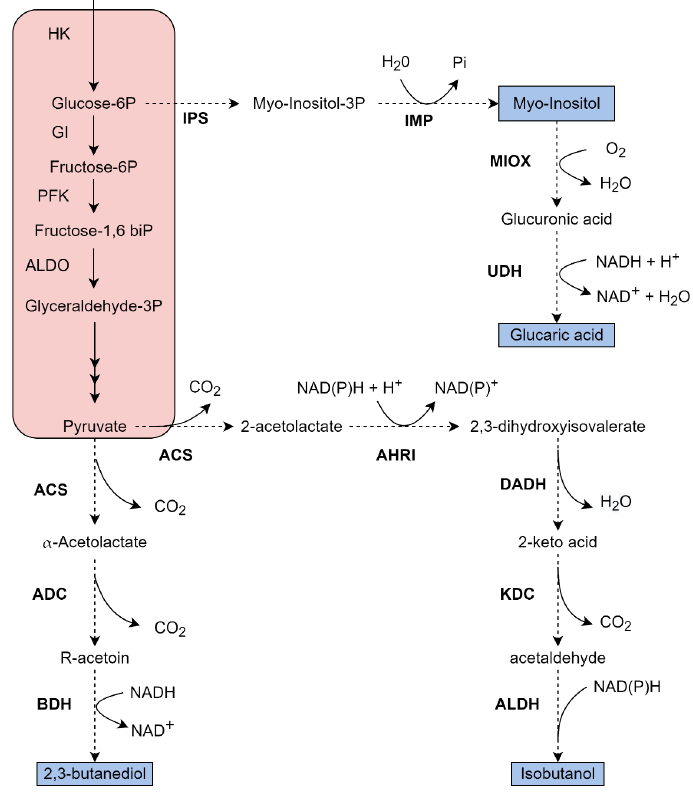
Figure 3. Metabolic pathway to glucose assimilation and production of a variety of chemicals by K. phaffii. Black arrows in the red boxes summarize the native glucose metabolism; dotted arrows rep- resent an overexpressed/heterologous pathway. Bold enzyme names represent an overex- pressed/heterologous enzyme, and the blue boxes represent the product formation. Some reactions are summarized for better comprehension, also, not all cofactors are represented in the figure. HK: Hexokinase; GI: Glucose isomerase; PFK: Phosphofructokinase; ALDO: Fructose-1,6-biphosphato